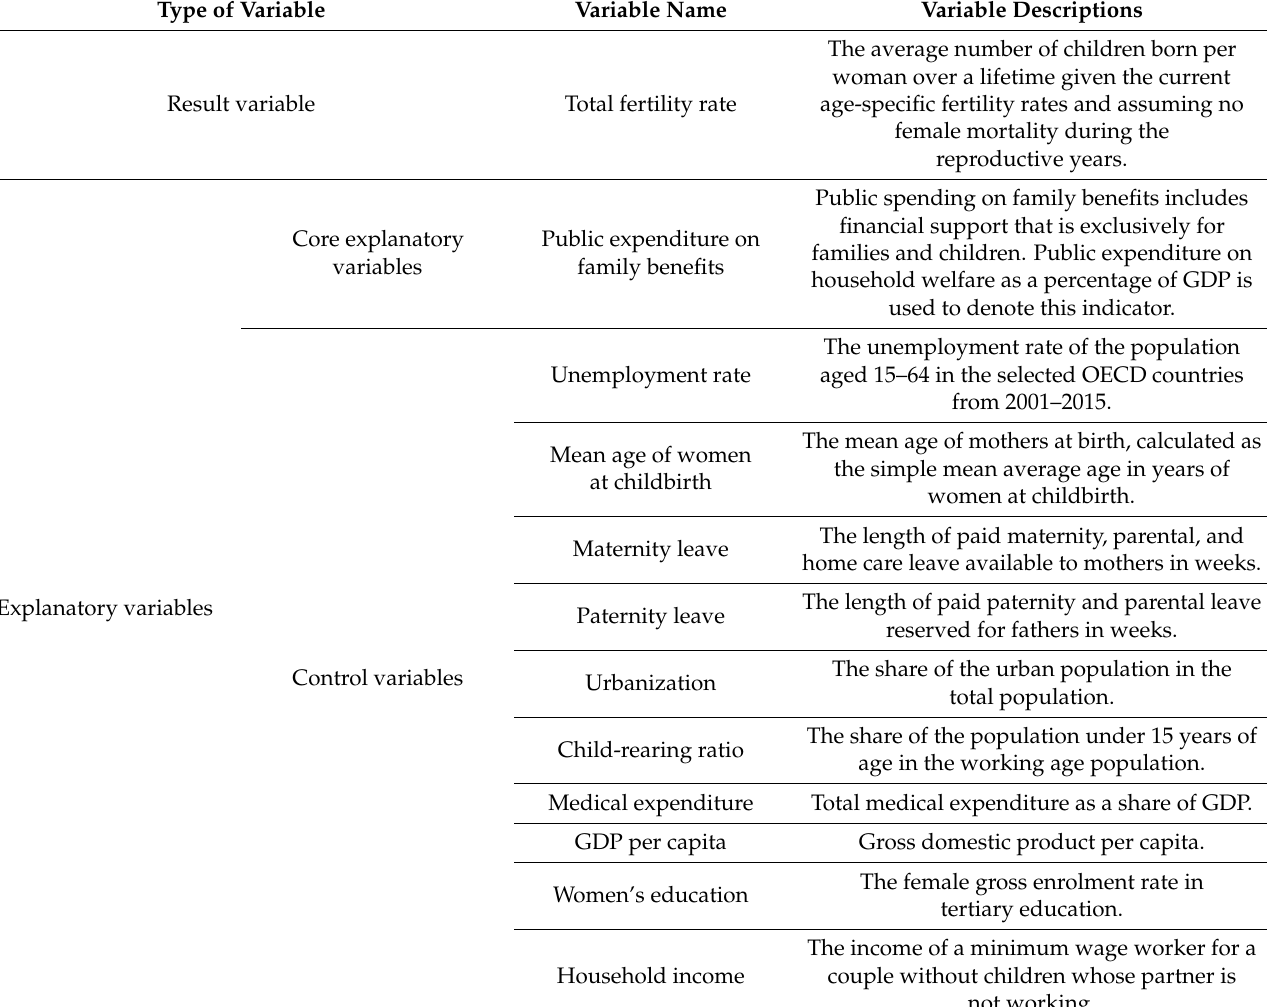
Table 2. Variable definitions and